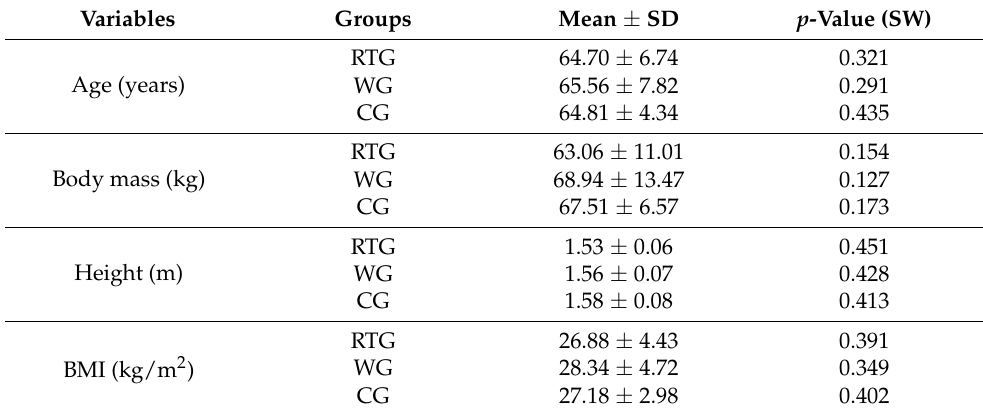
Table 1. Characterization of the sample ( n = 67).